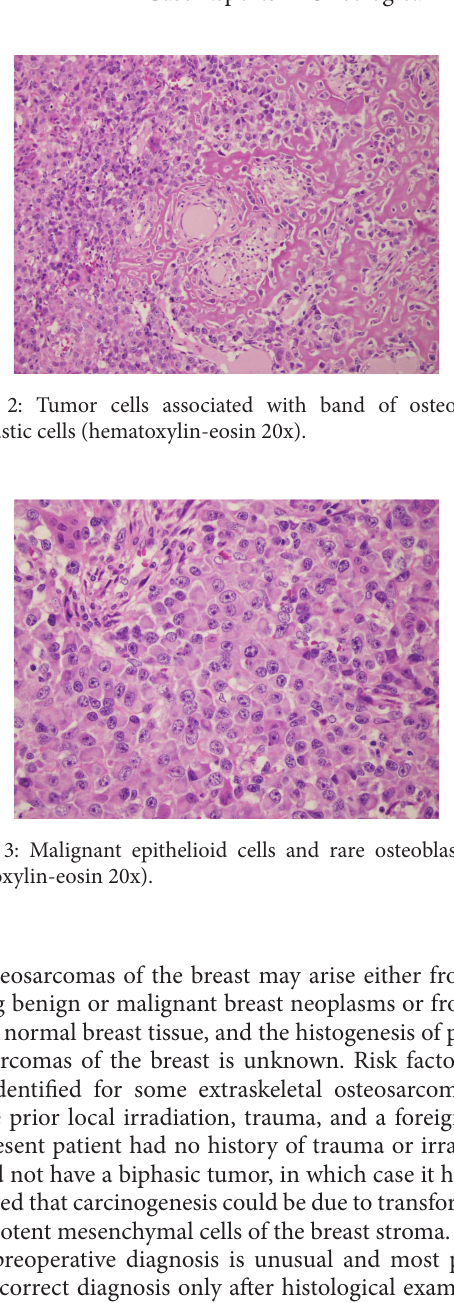
Figure 3: Malignant epithelioid cells and rare osteoblastic cells (hematoxylin-eosin